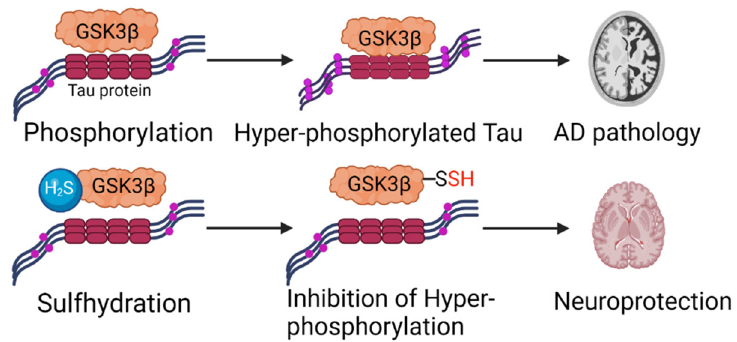
Figure 2. Proposed model of neuroprotection of AD afforded by H 2